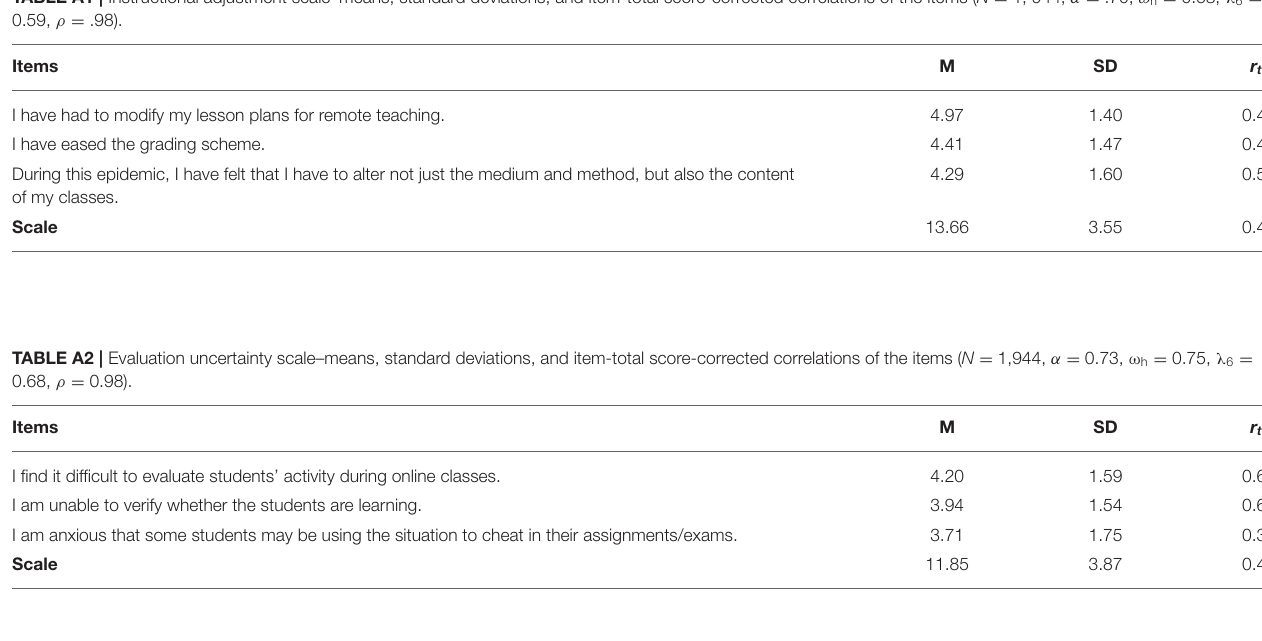
TABLE A3 | Perceived student coping scale – means, standard deviations, and item-total score-corrected correlations of the items ( N = 1,944, α = 0.72, ω h = 0.74, λ 6 = 0.69, ρ = 0.94). Items M SD r tt